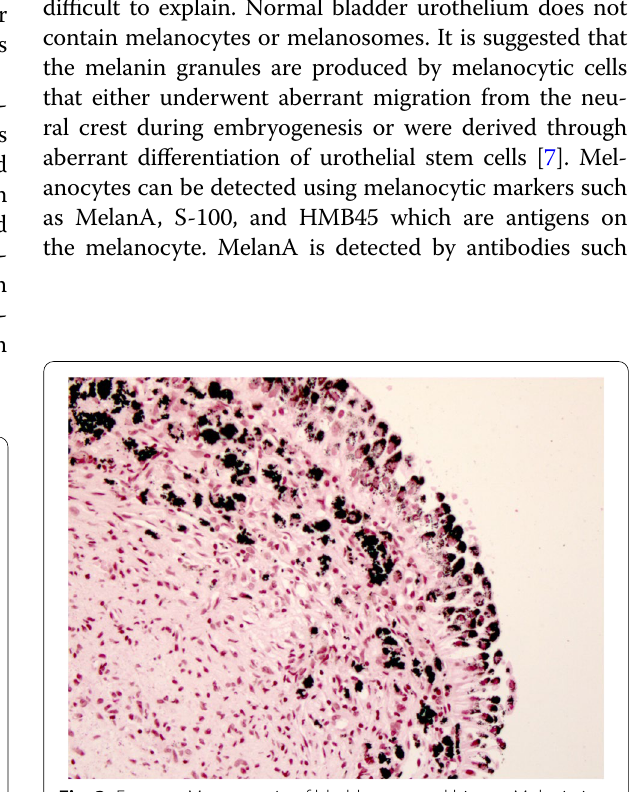
Fig. 3 Fontana‑Masson stain of bladder mucosal biopsy. Melanin is stained black with the stain and helps to diagnose bladder